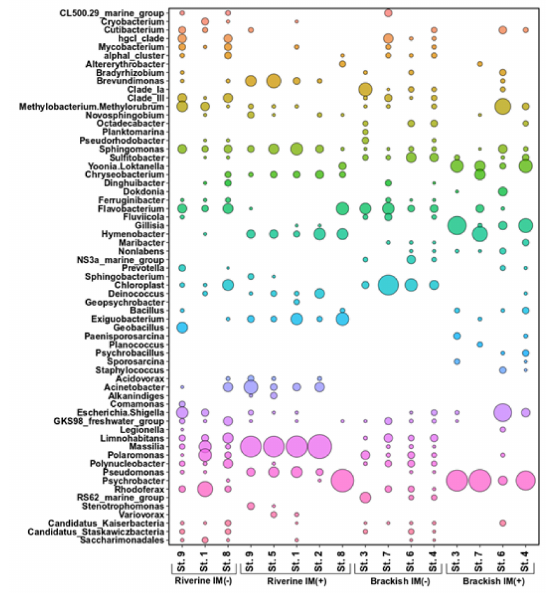
Figure 5. Bubble scatter plot of phylogenetic groups detected at each sampling site during the two sampling campaigns in the Pasvik